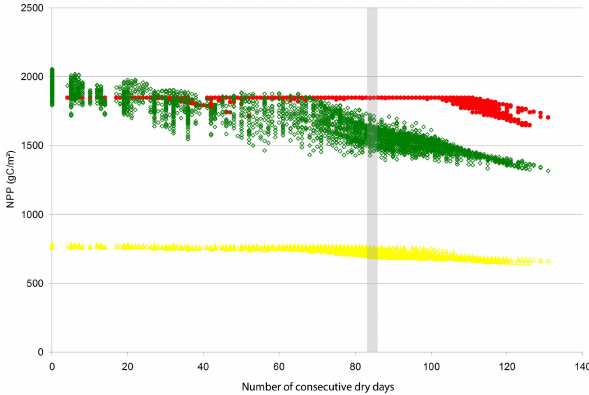
Fig. 5. Evolution of the NPP of 3 PFTs, as a function of the num- ber of consecutives dry days for Ngamakala (400m). In red, trop- ical/warm grass PFT (trg); In green, tropical raingreen trees PFT (trt); In yellow, woody desert plant type C3 and C4 PFT (wod). In grey, current number of consecutive dry days according to the cli- matic database (Leemans and Cramer,